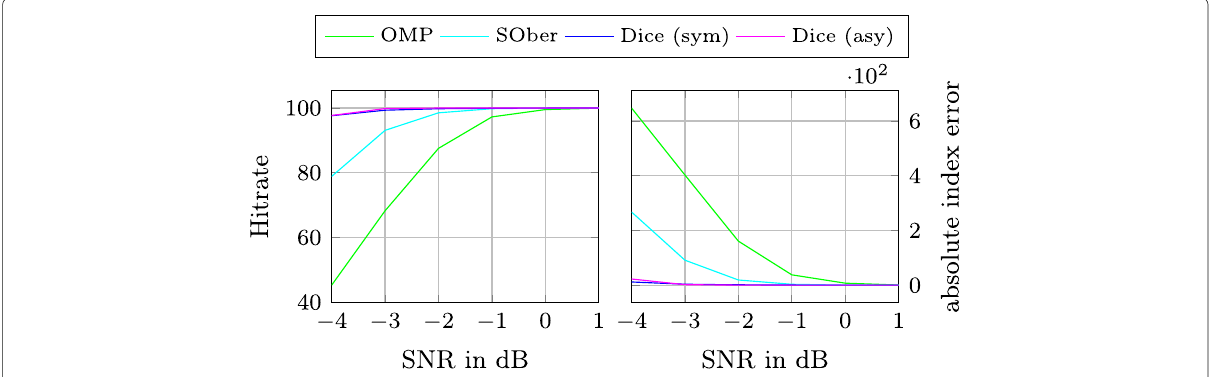
Fig. 4 Left hit rate over SNR, right absolute index error over SNR. Both at consecutive sample ratio